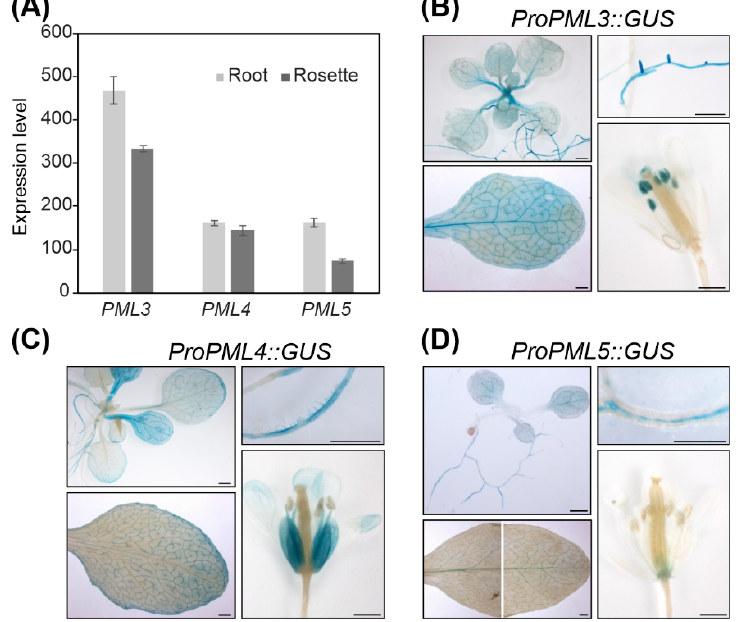
Figure 4. Analysis of PML3 , PML4 , and PML5 expression. ( A ) Expression levels were derived from the developmental map of the Arabidopsis Browser Database [29]. (For promotor analysis, various tissues of Arabidopsis line ProPML3::GUS ( B ), ProPML4::GUS ( C ), and ProPML5::GUS ( D ) were incubated in staining solution and analyzed for a blue precipitate of chloro-bromoindigo indicating β -Glucuronidase (GUS) activity. Please note that the leaf photograph in (D) is composed of two single photographs. Scale bar = 1 mm.